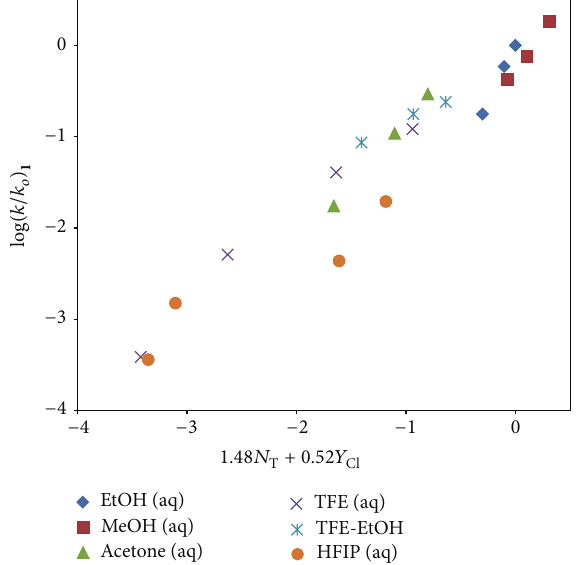
Figure 4: The plot of log (𝑘/𝑘 𝑜 ) for 9-fluorenylmethyl chloroformate Figure 3: The plot of log (𝑘/𝑘 𝑜 ) for 4,5-dimethoxy-2-nitrobenzyl + 0.52𝑌 ( 2 ) against log (𝑘/𝑘 𝑜 ) for phenyl chloroformate ( 3 ) in the thirty-three in the twenty pure and chloroformate ( 1 ) against 1.48𝑁 T Cl common pure and binary solvents studied. binary solvents studied.